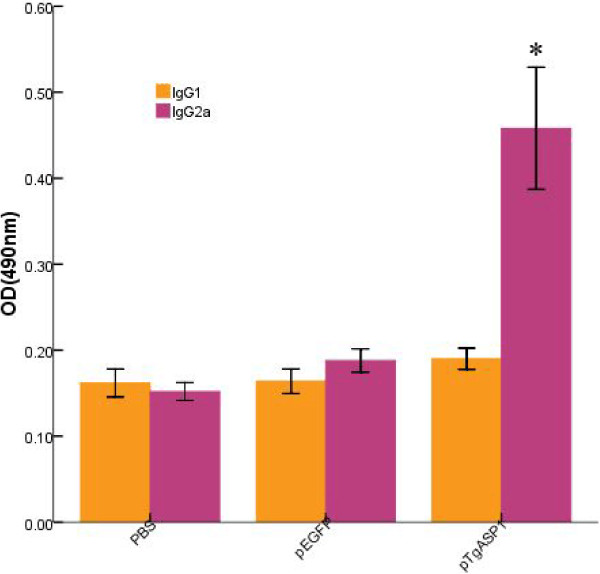
Distribution of IgG1 and IgG2a subtypes in pTgASP1-immunized mice. Serum levels of IgG1 and IgG2a were analyzed by ELISA two weeks after the final immunizations. Results are expressed as the means of the OD 490 ± SD and statistically significant differences (P < 0.05) are indicated by an asterisk (*), as compared with control groups.